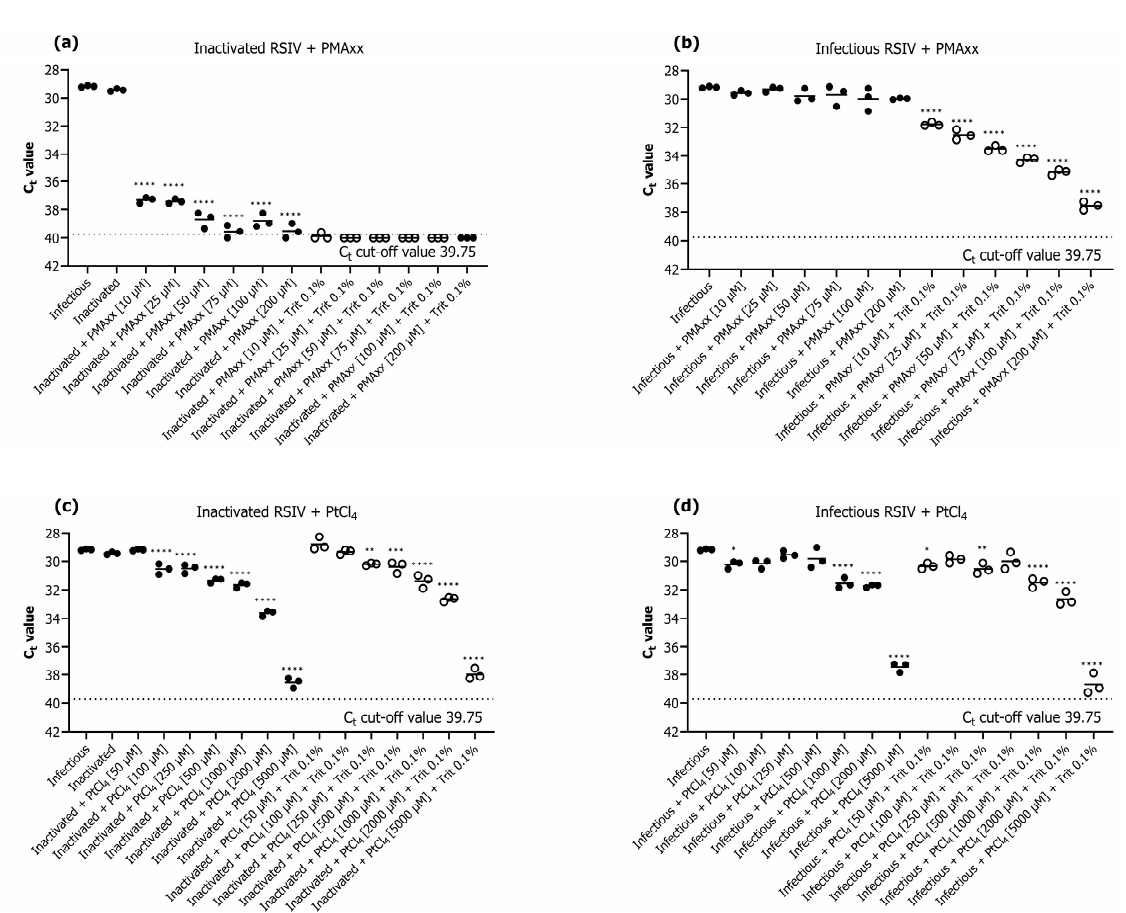
Figure 1. Evaluation of the performance of viability quantitative polymerase chain reaction (qPCR) for detection of inactivated and infectious red sea bream iridovirus (RSIV) using ( a , b ) propidium monoazide (PMAxx) dye and ( c , d ) platinum compounds (PtCl 4 ). The black dotted line represents the cut-off cycle threshold (C t ) values for qPCR. The solid line in each interval represents the average C t value. Asterisks indicate significant differences from infectious RSIV without added viability markers for each viability marker concentration. * p < 0.05; ** p < 0.01; *** p < 0.001; **** p < 0.0001.